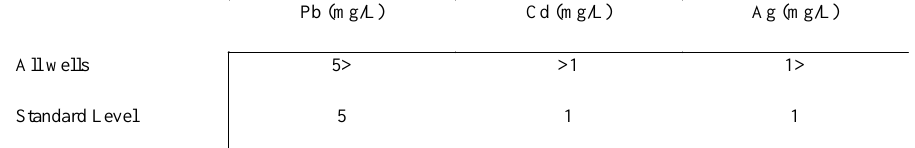
Table 6: The comparison of heavy metal concentration in the groundwater area with international standards